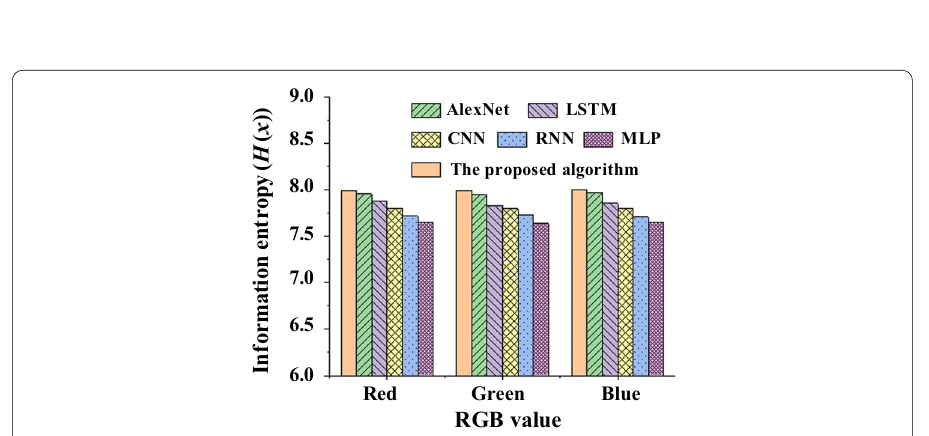
Fig. 9 The influence of different algorithms on the information entropy of pixel value at (0,